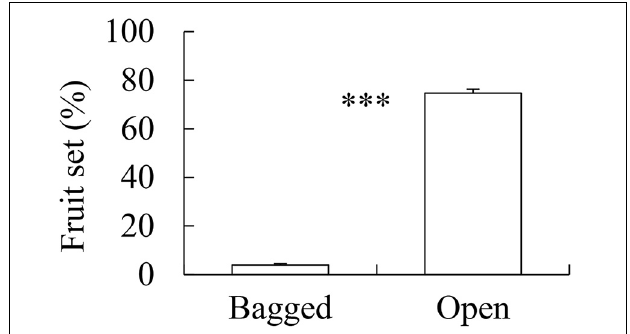
FIGURE 2 | The difference in apple fruit set between bagged and open treatments. *** p <